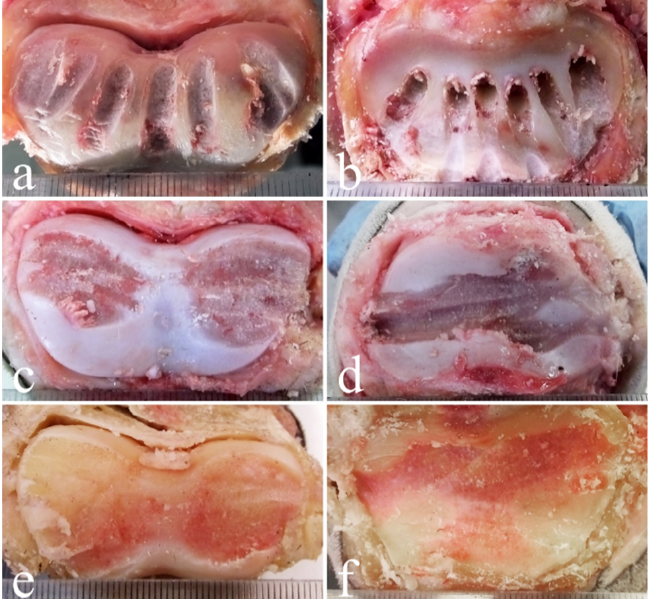
Figure 4. Distal surfaces of P1 ( a , c , e ) and proximal surfaces of P2 ( b , d , f ) of the hindlimb after dorsal drilling approach ( a , b ) and lateral drilling approach without ( c , d ) and with the use of digital fluoroscopy ( e , f ). The best cases, belonging to three different animals and obtained with the three different drilling techniques, are